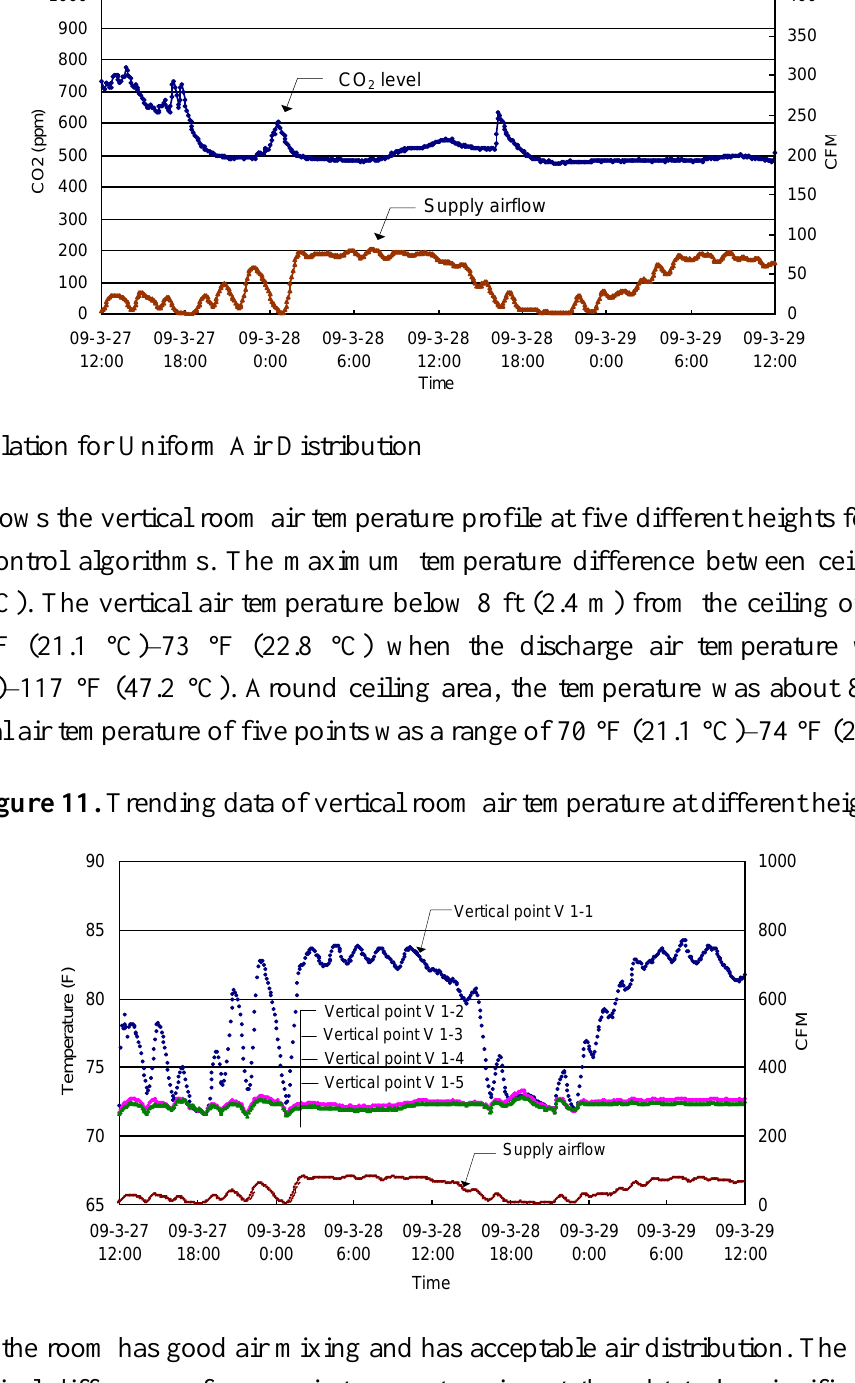
Figure 10. Trending data of room CO